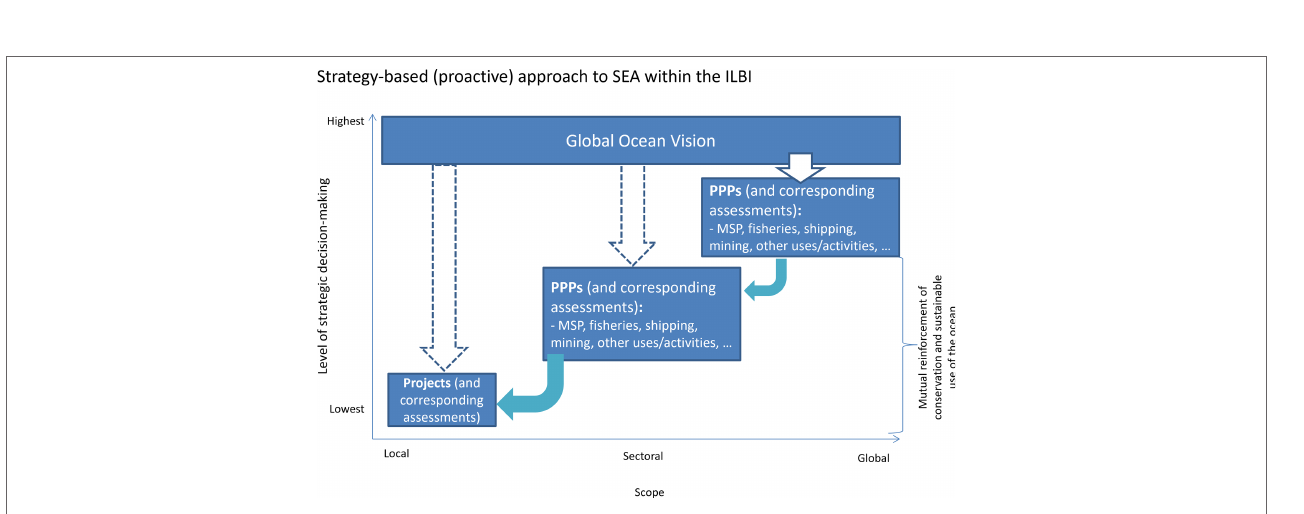
FIGURE 1 | Traditional, EIA-based (reactive) approach to SEA, where SEA is at best a greening mechanism of a corresponding high-level management instrument. indicates potential